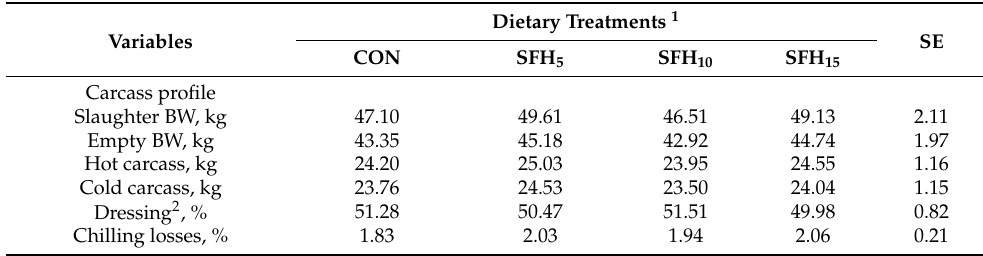
Table 4. Carcass characteristics of growing Awassi lambs fed the experimental diets containing different levels of sunflower